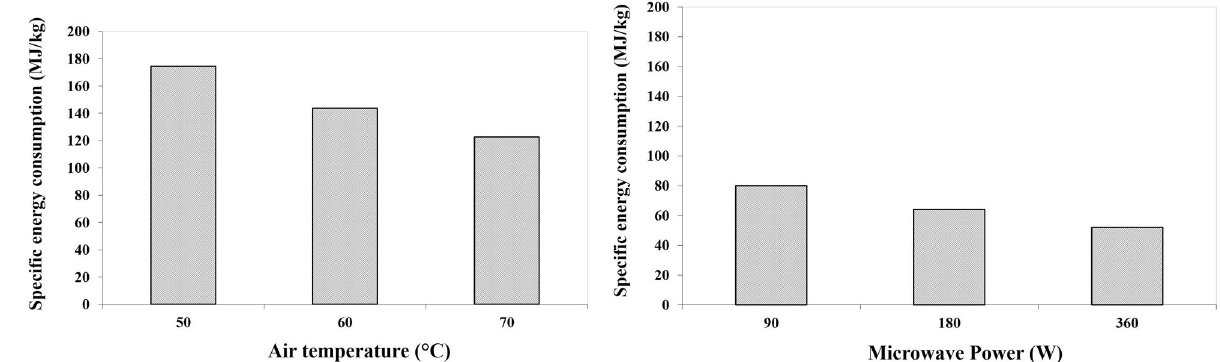
Figure 4. Variations of specific energy consumption for drying process of apple slice in different: ( a ) air temperature, ( b ) microwave power.